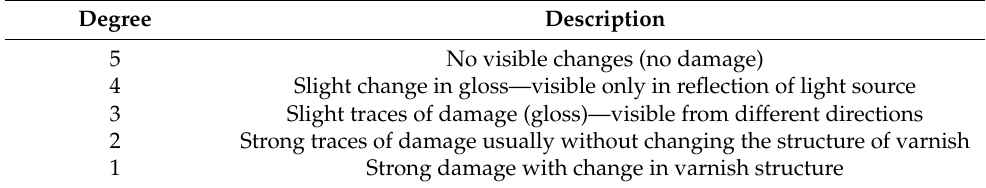
Table 5. Surface resistance to cold liquids: degree and